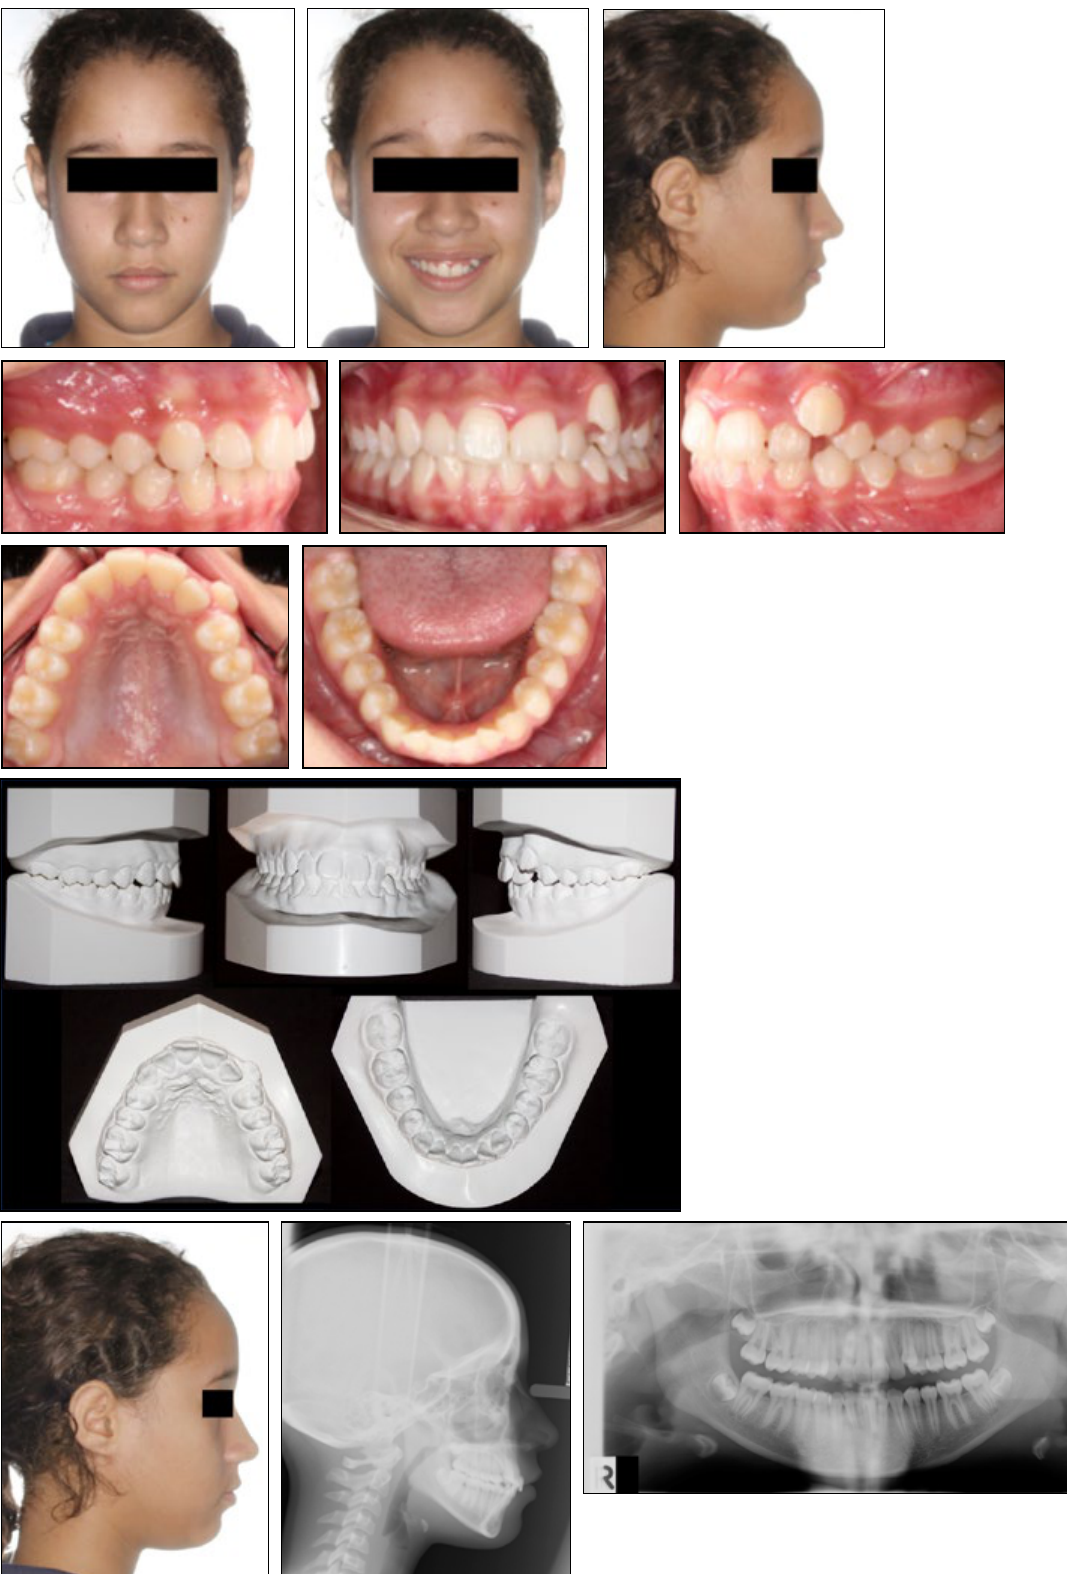
Figure 1. An example of patient records, including intra- and extra-oral photographs, panoramic and lateral cephalometric radiographs and study